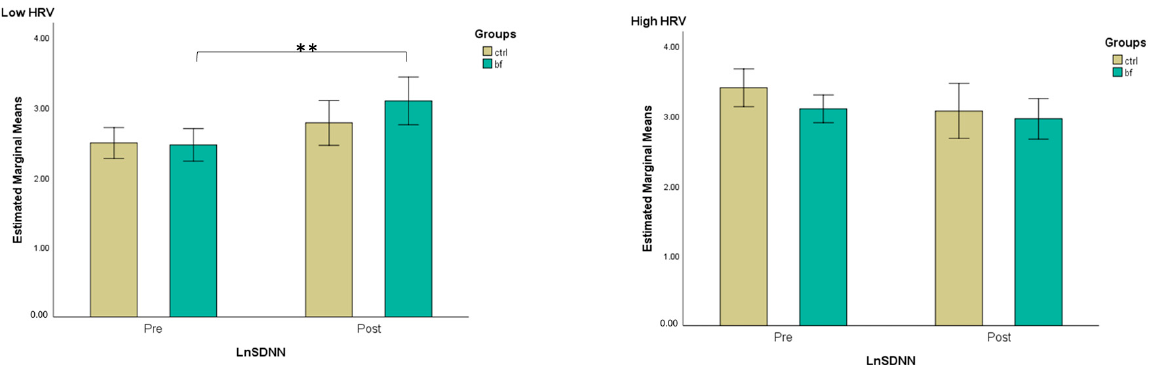
Figure 5. Estimated marginal means (with 95% confidence intervals) for ln SDNN pre ‐ and post ‐ intervention across groups, separated by low and high RMSSD level at baseline (**— p < 0.01—T ‐ test for dependent samples).